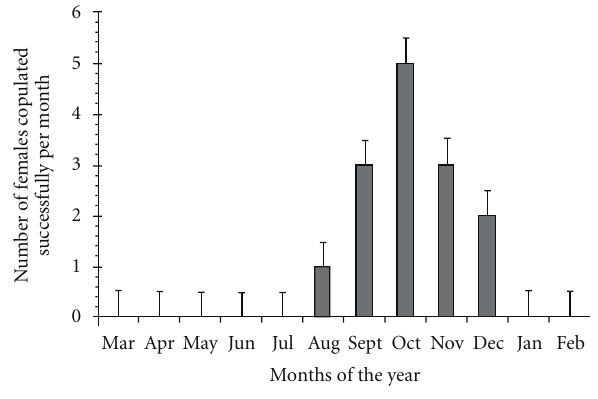
Figure 1: Mating frequency of the free-ranging domestic dogs in successive months as observed from March 2008 to February